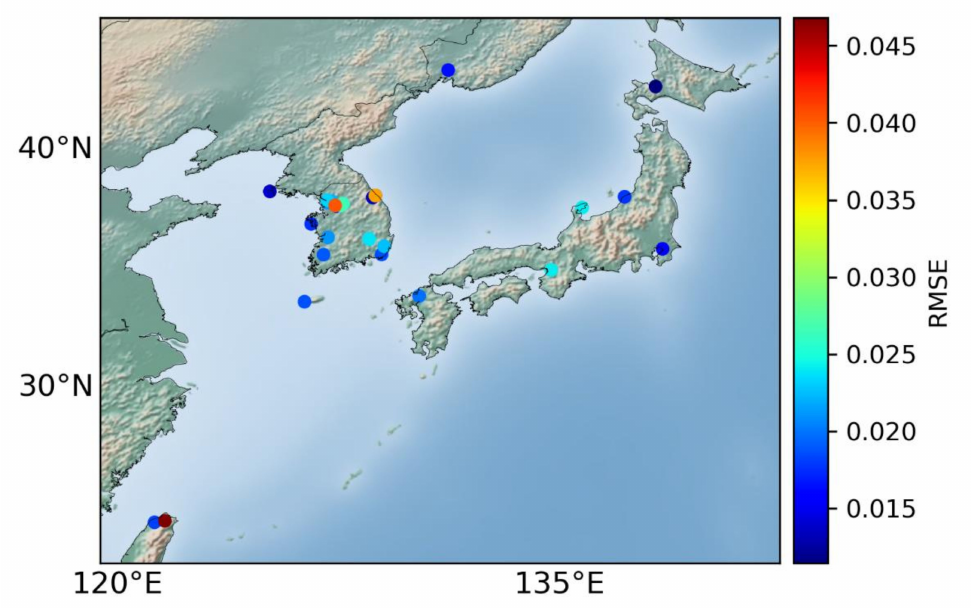
Figure 5. RMSEs of GOCI LSR for band 1 at 28 AERONET sites. The color bar indicates the RMSE for each AERONET